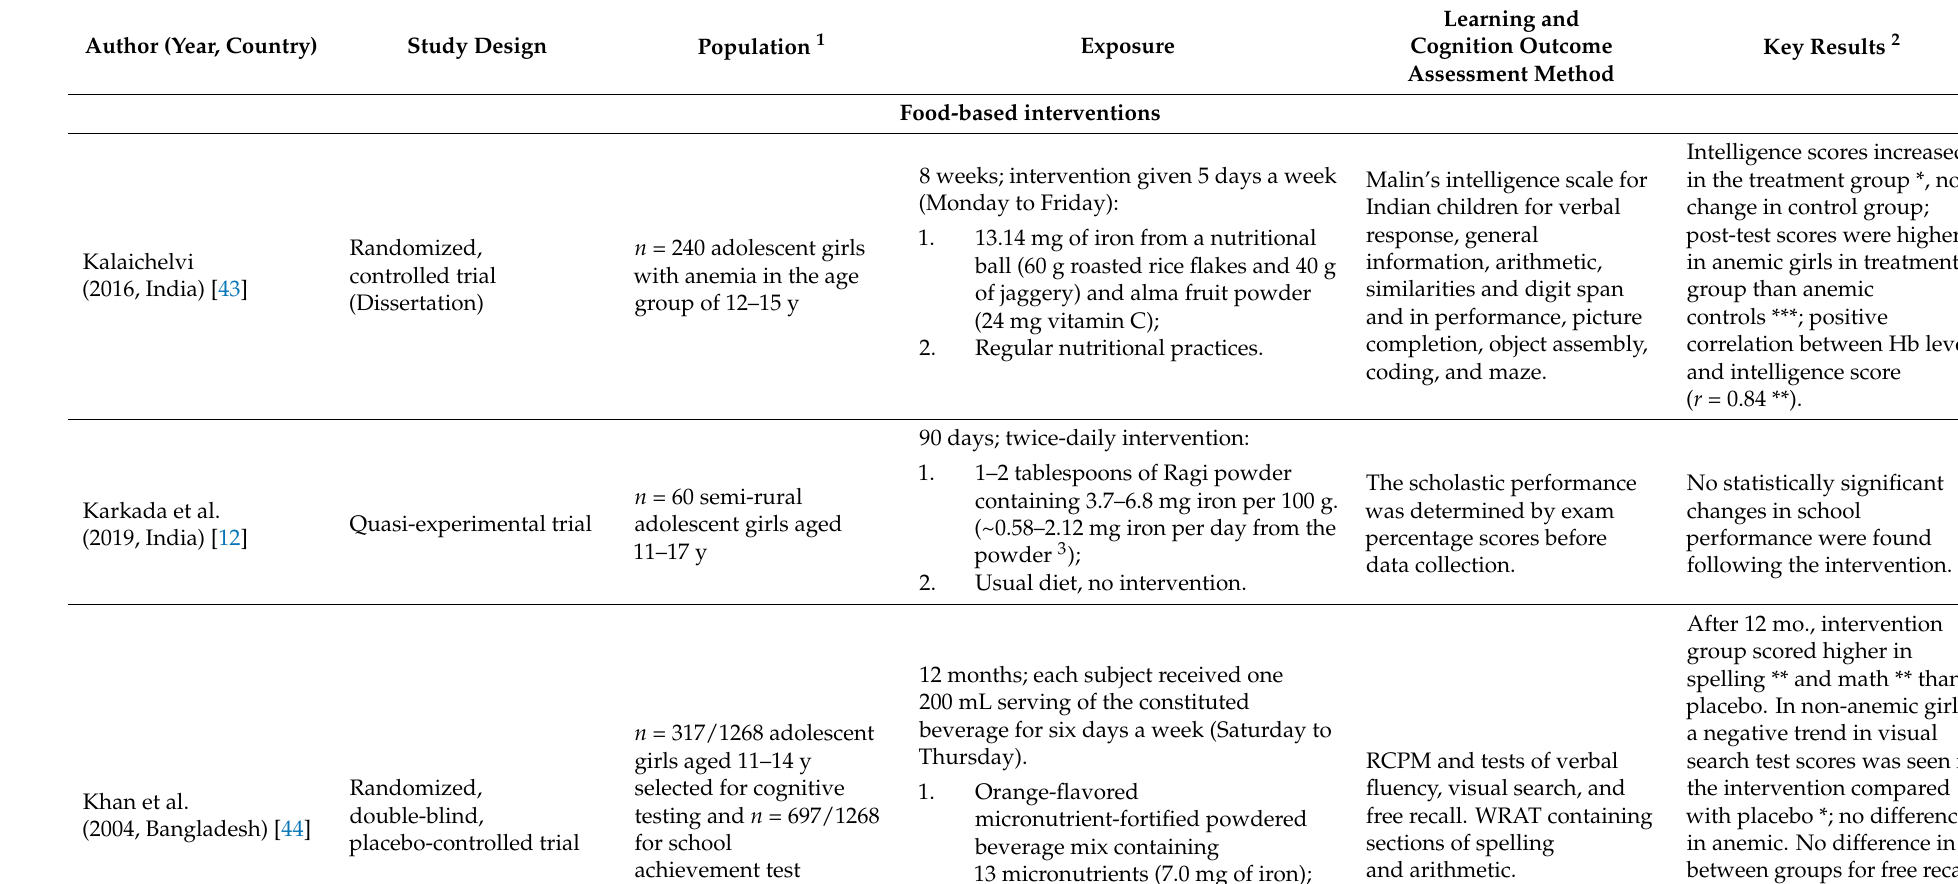
Table 2. Description and results of iron-containing intervention studies examining dimensions of academic performance and cognitive